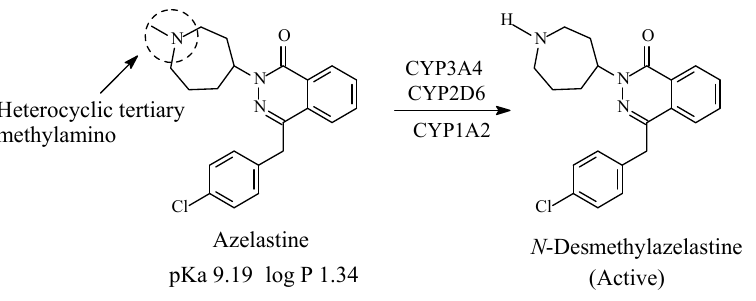
Figure 23. Metabolism of azelastine.